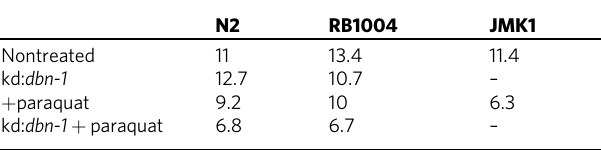
Treatment with dbn-1 RNAi with or without paraquat-induced oxidative stress. ( – ) No siRNA treatment was performed with JKM1 (complete knockout) RNAi RNA interference, siRNA small interfering RNA